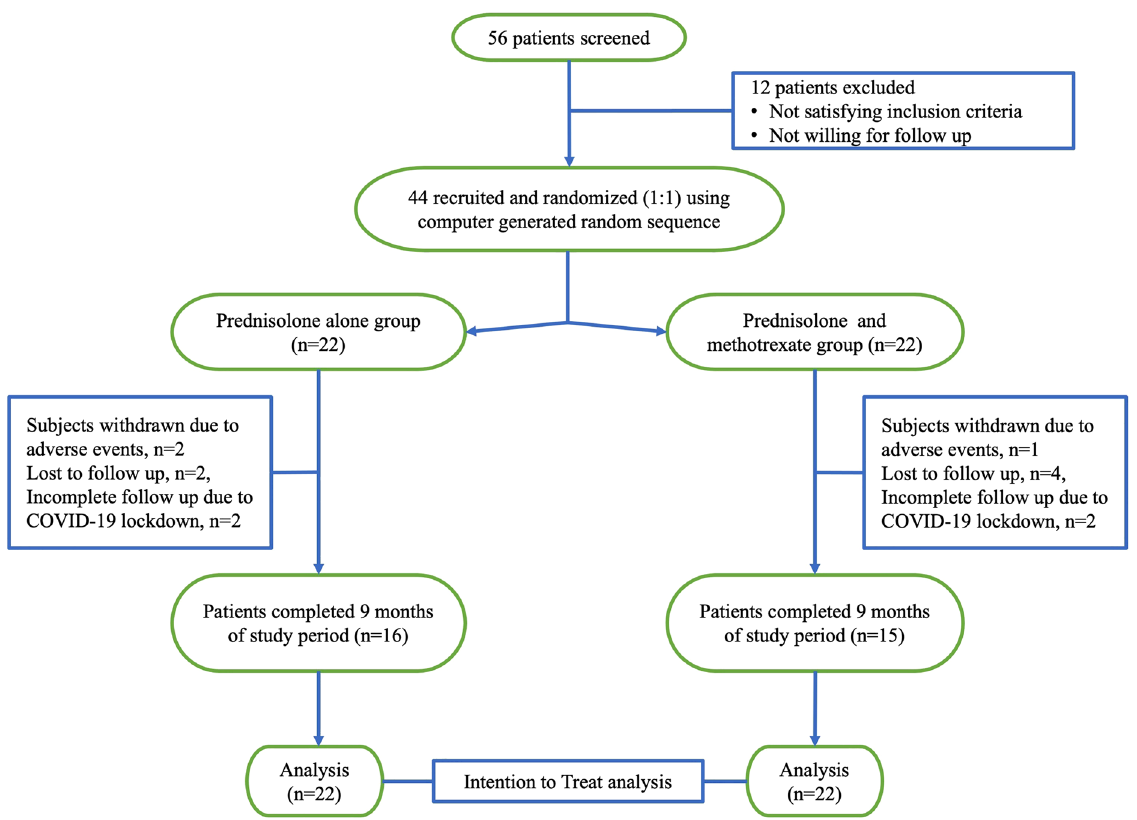
Figure 1. CONSORT diagram of study participants with inclusion and exclusion of patients and allocation of patients into